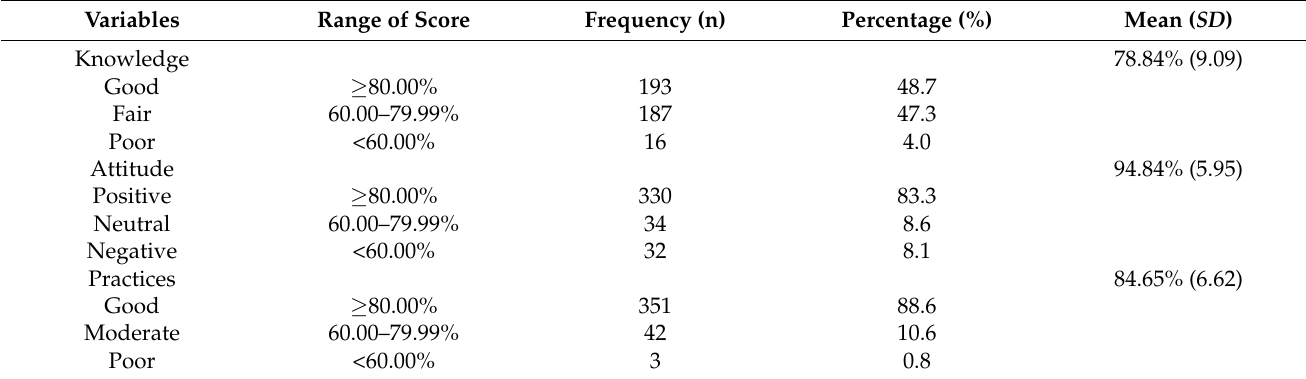
Table 1. Level of KAP of food safety among FTVs during COVID-19 pandemic (N =